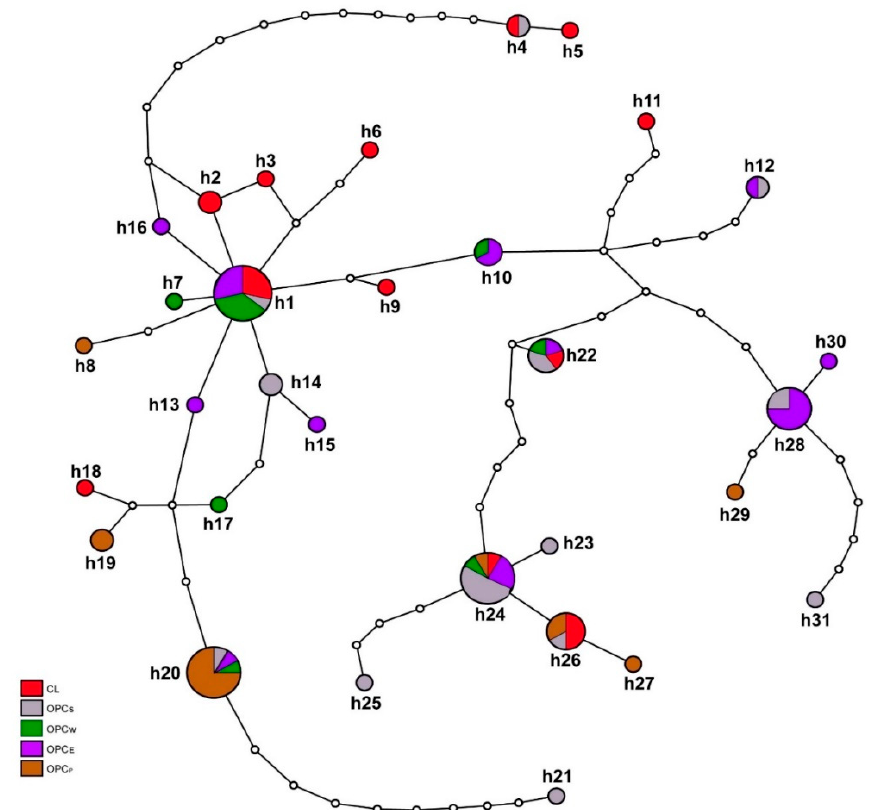
Figure 3. Pattern of 31 mtDNA control region haplotypes in Colombian Creole sheep constructed using the TCS program and plotted with tcsBU. Each haplotype is represented by a pie chart with size proportional to the number of sequences of each breed. The number of haplotypes corresponds to those indicated in Table 2 and Table S4. The small white circles indicate mutational changes. The five Creole breeds are indicated by the colors shown in the legend. CL—wool Creole; OPC E —Ethiopian; OPC S —Sudan; OPC P —Pelibuey; OPC W — Wayúu .